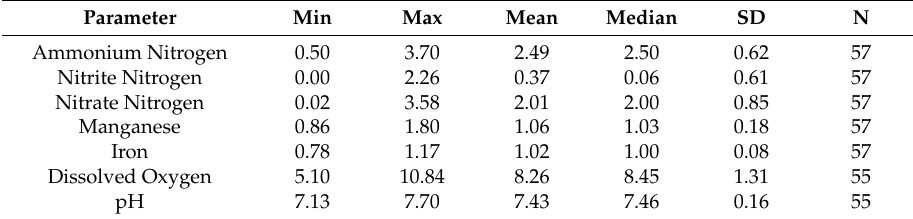
Table 3. The physicochemical quality of water directed to biofilters.